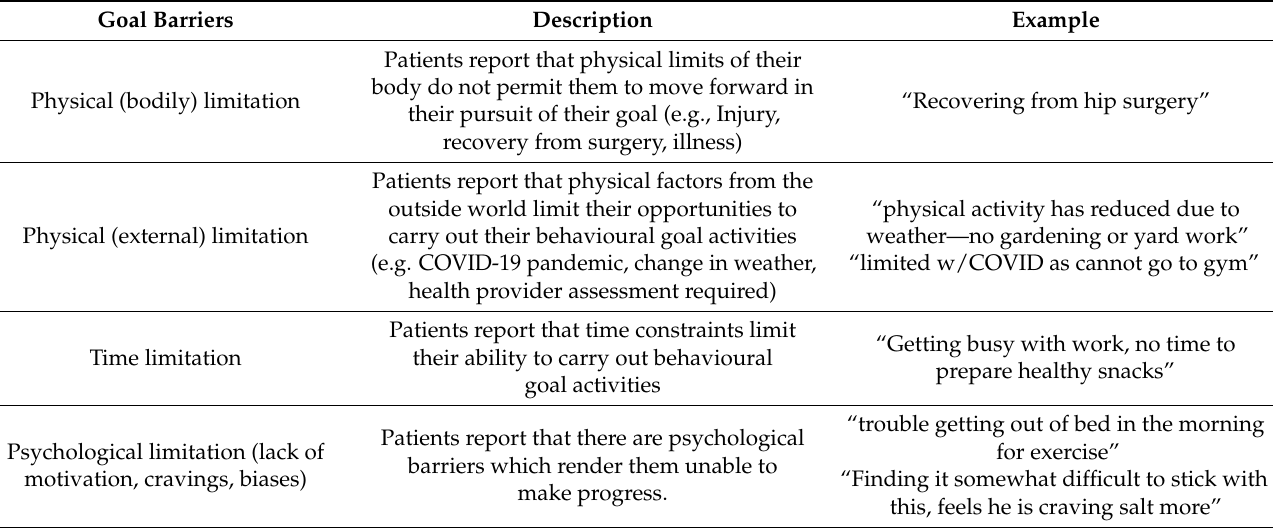
Table 3. List of barriers to patient behavioural